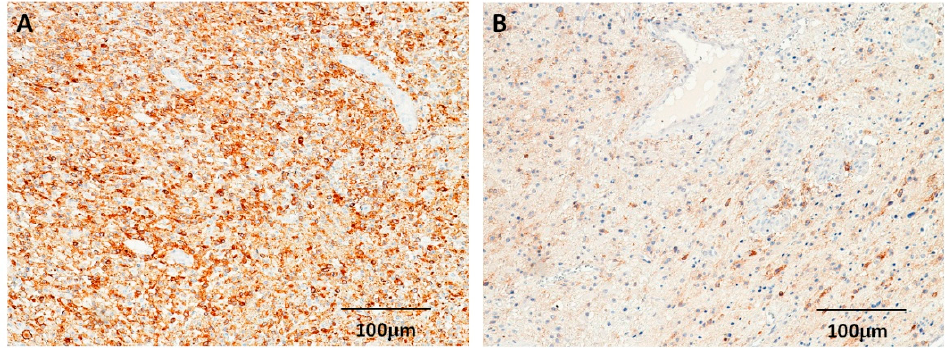
Figure 1. Immunohistochemical staining for p53 in astrocytomas. ( A ) High-level p53 expression in